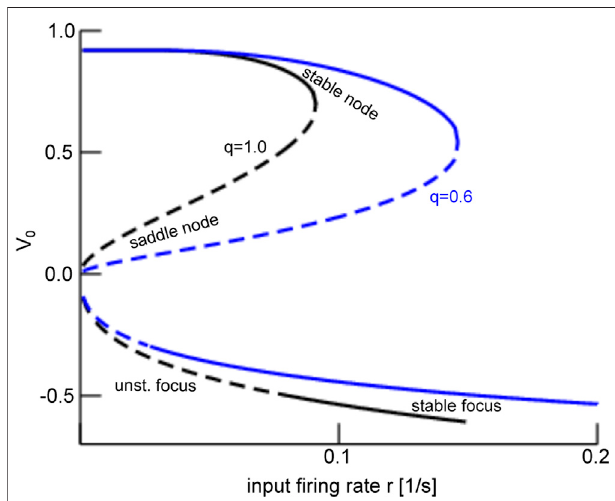
FIGURE 12 | Equilibria of the mean- fi eld V ( t ) for the Poisson partial stimulation. For global stimulation q (cid:1) 1 . 0, the system is always monostable with three equilibria at low input fi ring rates and a single equilibrium at large input fi ring rates. Increasing the input fi ring rate from low to large fi ring rates, the system jumps from the upper stationary state (stable node) to a stable focus on the lower stationary state via a saddle-node bifurcation. For partial stimulation q (cid:1) 0 . 6, the system is monostable with three equilibria at lowinput fi ringrates.Forlargerinputrates,thesystemisbistableandpassesa saddle-node bifurcation inducing a transition from a stable node to an stable focusatenhancedinput fi ringrate r .Solid(dashed)linesmarkstable(unstable) states, black- and blue-colored lines denote equilibria for global and partial stimulation, respectively. The bifurcation diagram of the mean- fi eld W ( t ) is